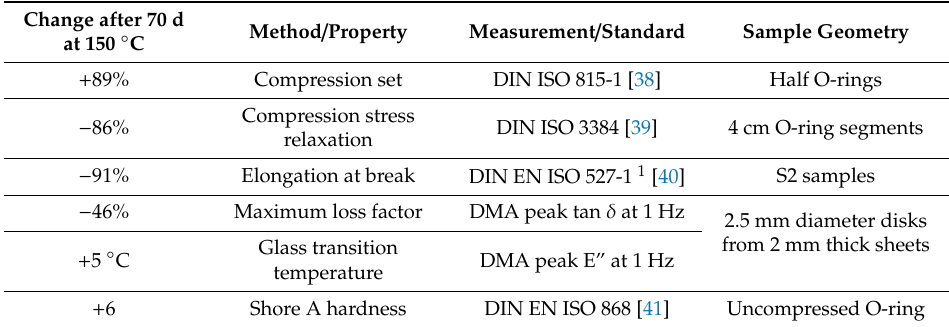
Table 4. Correlation of the aging state defined as the end of the lifetime with di ff erent methods